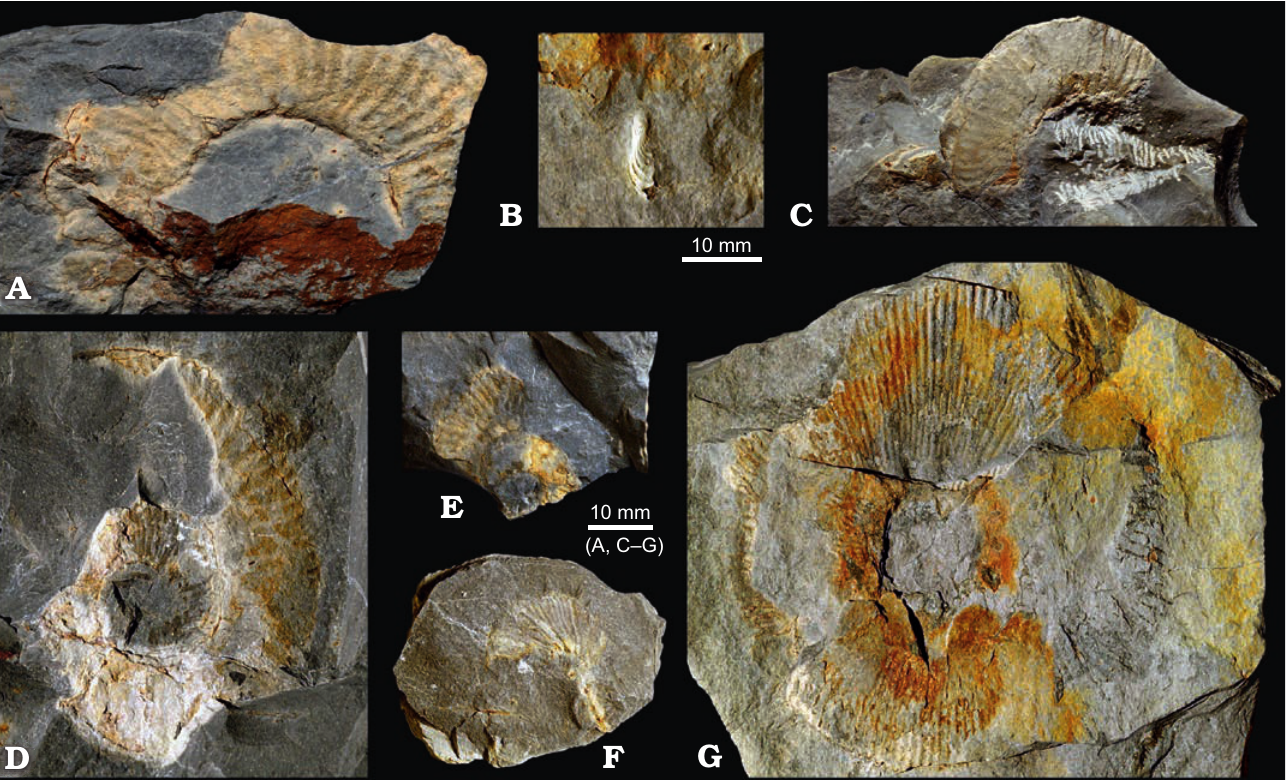
Fig. 3. The Lower Cretaceous ammonites from the Kościeliska Marl Formation in the Lejowa Valley, Tatra Mountains, Poland. A , C – E . Criosarasinella cf. subheterocostata Reboulet, 1996. A . ZPAL Am. 25/19. C . ZPAL Am. 25/7. D . ZPAL Am. 25/17. E . ZPAL Am. 25/14. B . Calcite valve of apty­ chus Didayilamellaptychus seranonis (Coquand, 1841), ZPAL Am. 25/12. F . Spitidiscus cf. cankovi Vašíček and Michalík, 1986, ZPAL Am. 25/9. G . Olcostephanus densicostatus (Wegner, 1909), ZPAL Am. 25/4. All in lateral